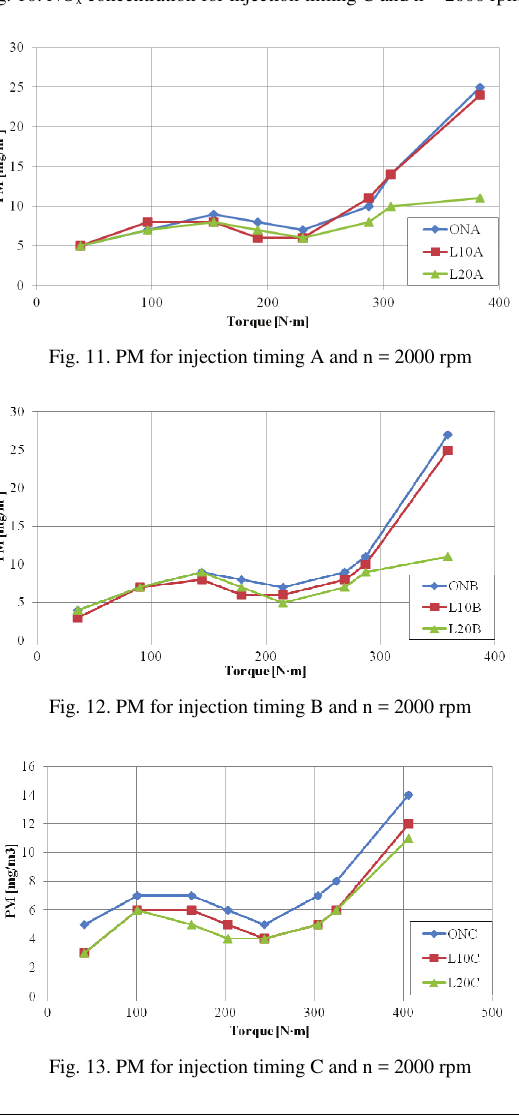
Fig. 10. NO x concentration for injection timing C and n = 2000 rpm